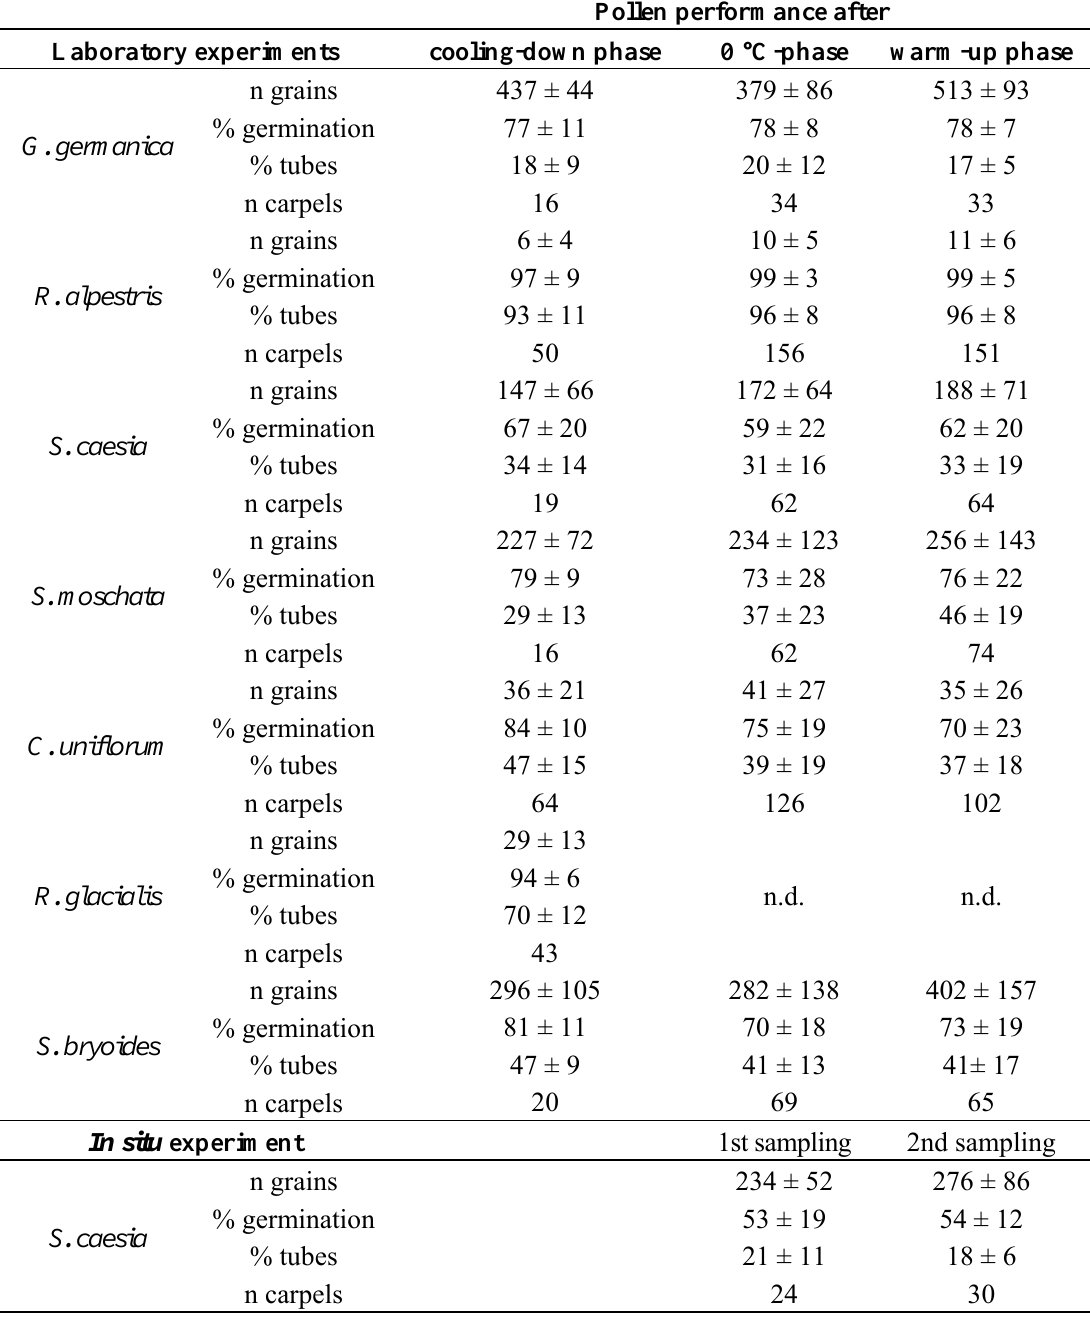
Table 2. Pollen performance in the laboratory experiments and in the in situ experiment. Mean number ± SD of pollen grains per stigma lobe, germinated pollen grains and pollen tubes in the style after different phases. n carpels: number of investigated carpels per plant species and phase; n.d. not determined. As there were no significant differences among exposure times in the 0 °C and the warm-up phase (Kruskal–Wallis test) data of the respective phase were pooled together and a total average was